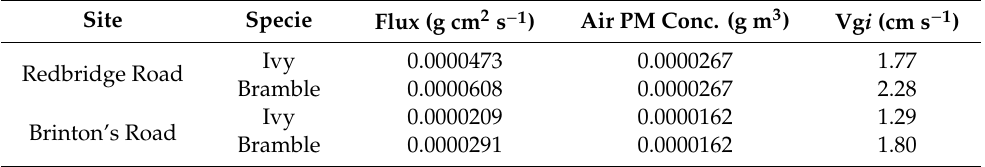
Figure 7. Time series of daily average PM10 concentrations at the AURN sites for Site 1 Redbridge Road and Site 2 Brinton’s Road and Redbridge Road, June 2017. (For this time-period, no data were available after 19 June for Site 1 and before 5 June for Site 2.). Table 2. Values of flux, PM10 air concentrations and deposition velocities for Redbridge and Brinton’s Road